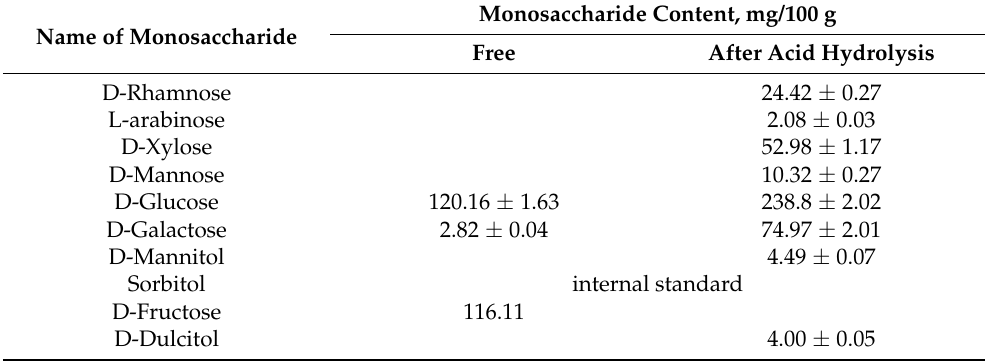
Table 1. Qualitative composition and quantitative content of monosaccharides in the herb extract of A. eupatoria .